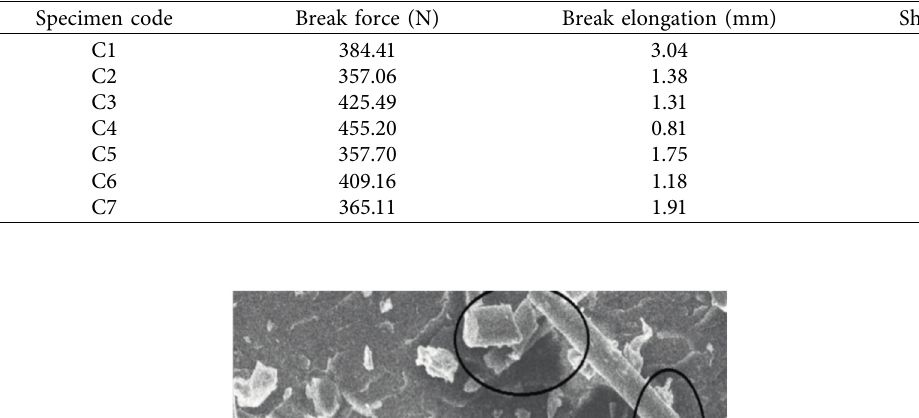
Figure 8: Shear strength of hybrid and nonhybrid GFRP composites with cement fillers. Table 3: Shear test results.